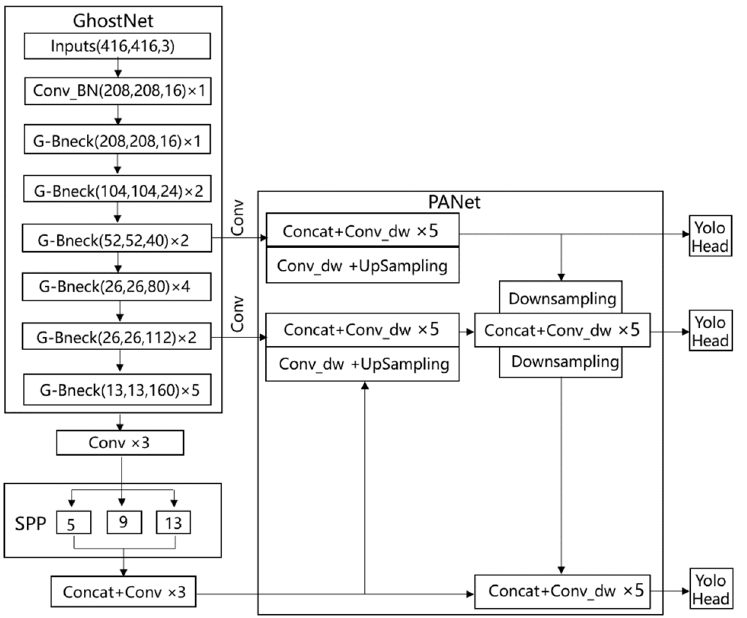
Figure 4. Ghostnet–YoloV4